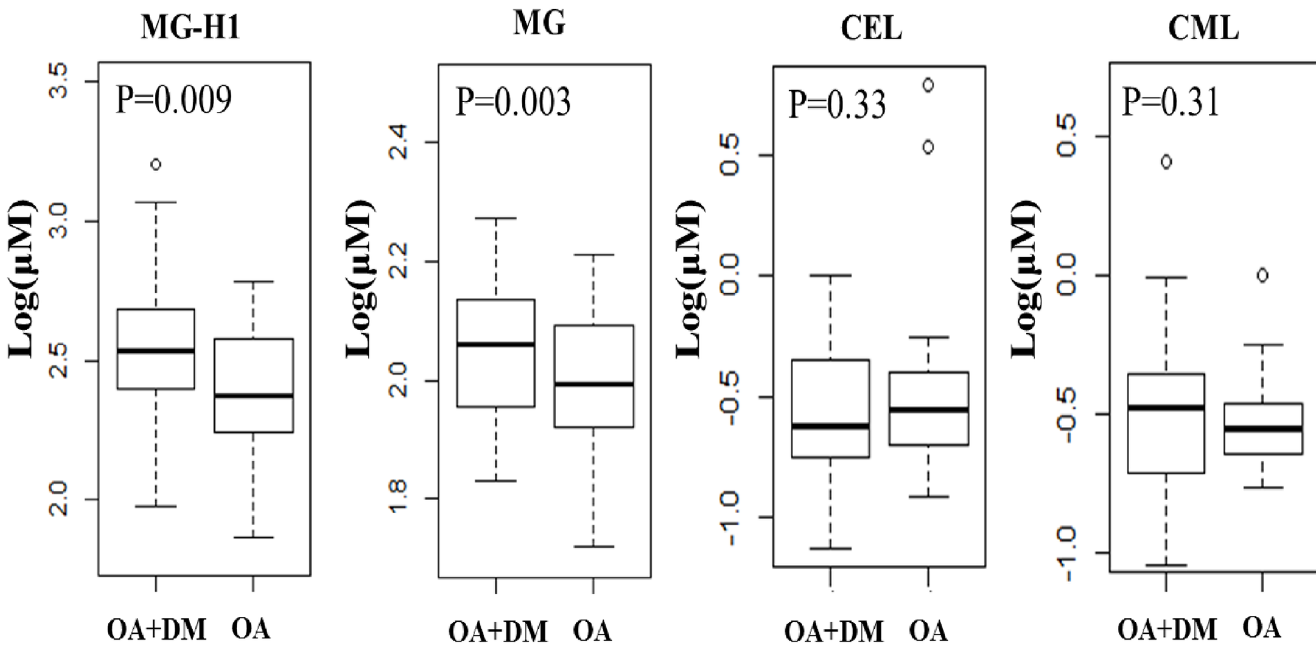
Fig 1. The concentrations of MG-H1, MG, CEL and CML in SF of OA and OA+DM patients. (DM: diabetes). P values were adjustedfor sex, age and BMI.